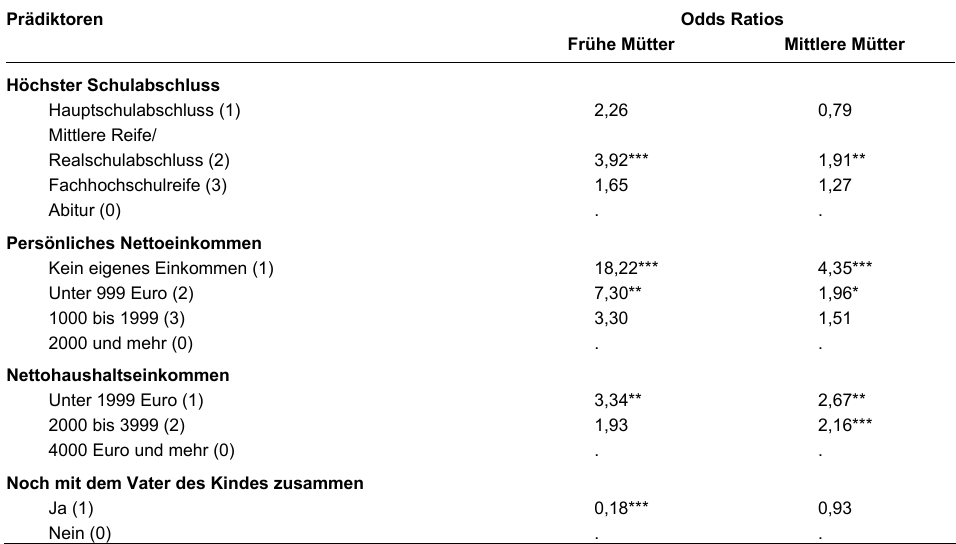
Frühe Mütter Mittlere Mütter